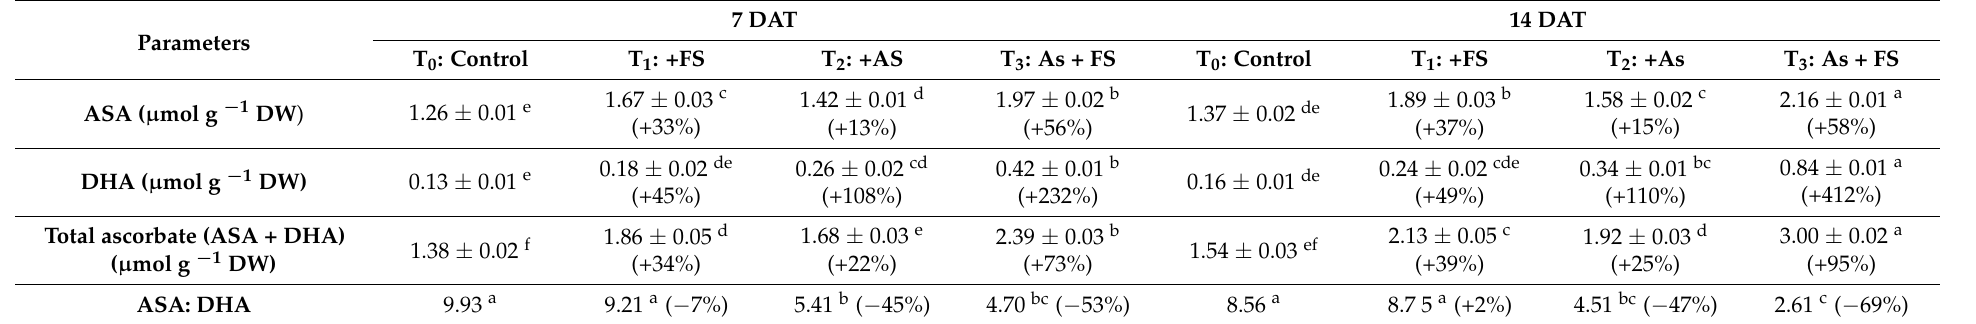
Table 1. Impact of iron sulfate (T 1 : +FeSO 4 ), arsenic stress (T 2 : +As) and iron sulfate supplementation during As stress (T 3 : As + FeSO 4 ) on contents of ascorbate (ASA), dehydroascorbate (DHA), total ascorbate (ASA + DHA) and ratio ASA:DHA in the leaf of Brassica juncea studied 7 and 14 days after treatment (DAT). 7 DAT 14 DAT Parameters